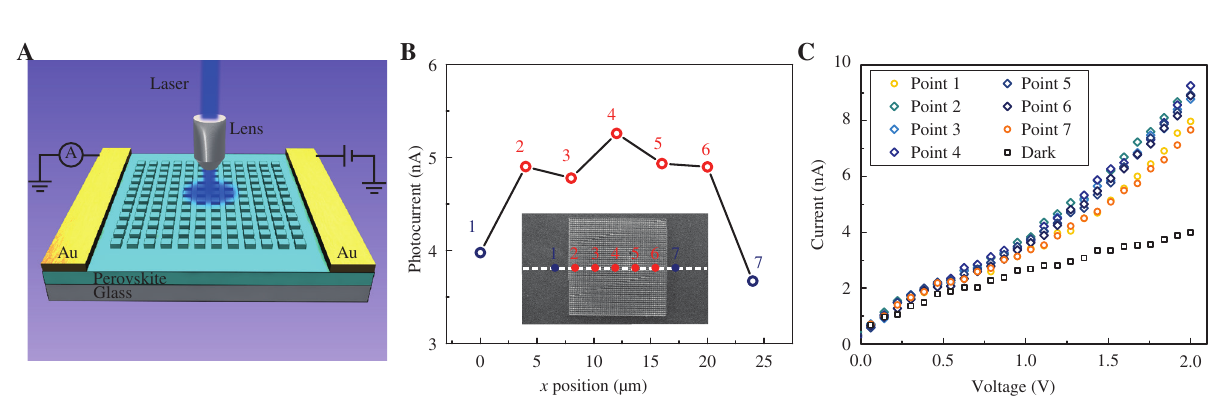
Figure 6: Electrical characteristics of the metamaterial. (A) Measurement setup used for the electrical measurements. (B) Photocurrents at seven excitation locations of the 442-nm laser (the spot diameter of 3 μ m and the power density of 2.16 W/cm 2 ) under the bias of 2 V. Red-colored points (marked by 2–6) and blue-colored points (marked by 1 and 7) represent the excitation locations inside and outside the metamaterial, respectively. Inset: the SEM image of the sample with the corresponding locations of the seven points studied here. (C) I-V curves of the seven points marked in (B). The HOIP metamaterial has t ≈ 280 nm, p ≈ 402 nm, d ≈ 120 nm, and w ≈ 223 nm, while the flat HOIP film has a thickness of 400